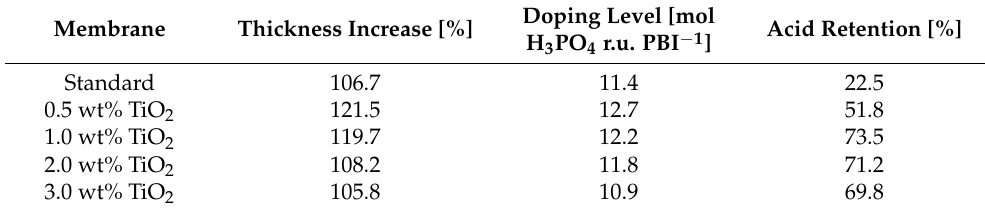
Table 1. ADL, thickness increase and acid retention